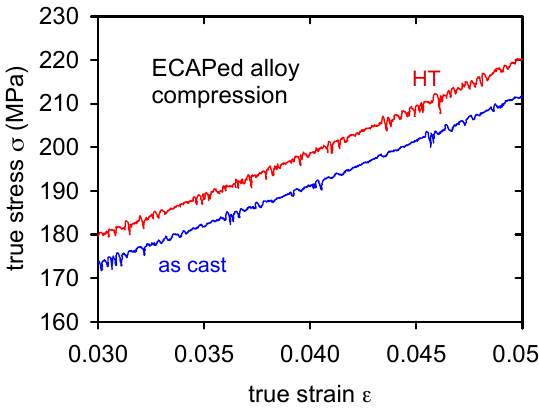
Figure 10. Serrated flow estimated for the ECAPed alloy during deformation in compression.